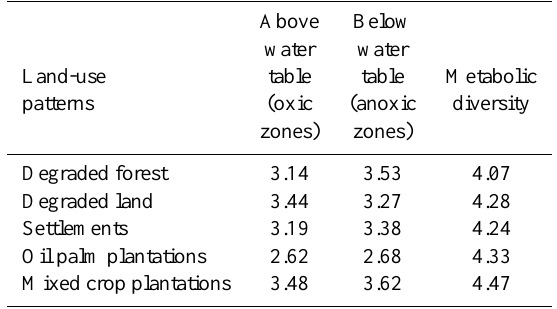
Table 1. Shannon diversity indices for different land-use patterns based on 16S rDNA and metabolic diversity.